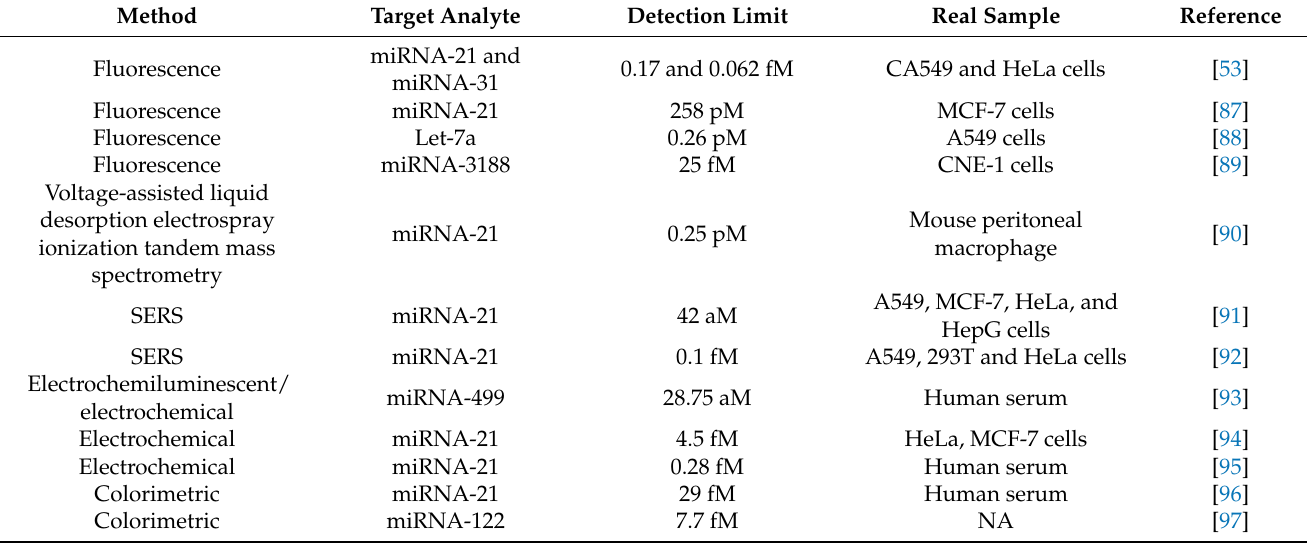
Table 1. DSN-based methods for miRNA